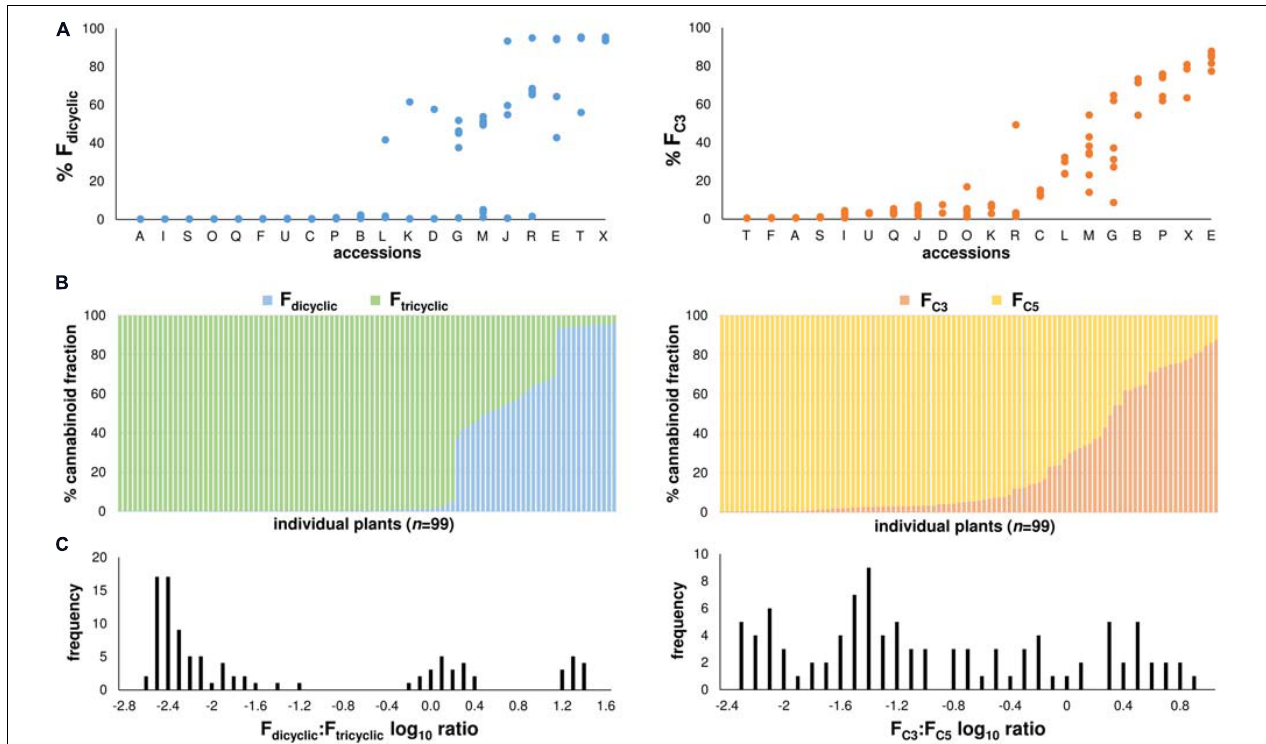
FIGURE 3 | (A) F dicyclic as well as F C3 chemotypic variation of mature plants within accessions. Accessions ordered on the x -axis from low to high chemotypic values. F dicyclic as well as F C3 values on the y -axis describe the relative abundance of dicyclic as well as C3-alkyl cannabinoid fractions. Letters specify accession ID ( Table 1 ). (B) Distribution patterns of the major F dicyclic /F tricyclic as well as F C3 /F C5 values of 99 Cannabis plants at maturation. Individual plants ordered on the x-axis from low to high F dicyclic as well as F C3 chemotypic values. F dicyclic /F tricyclic as well as F C3 /F C5 values on the y -axis describe the relative abundance of dicyclic as well as C3-alkyl cannabinoid fractions. (C) F dicyclic : F tricyclic as well as F C3 : F C5 log10 ratios of 99 mature Cannabis plants. Log10 frequency distributions of F dicyclic : F tricyclic chemotypic values show three discrete distributions, while Log10 frequency distributions of F C3 : F C5 chemotypic values have no obvious distribution pattern; C 5 -alkyl cannabinoid fractions (F C5 ); C 3 -alkyl cannabinoid fractions (F C3 ); dicyclic cannabinoid fractions (F dicyclic ); and tricyclic cannabinoid fractions (F tricyclic